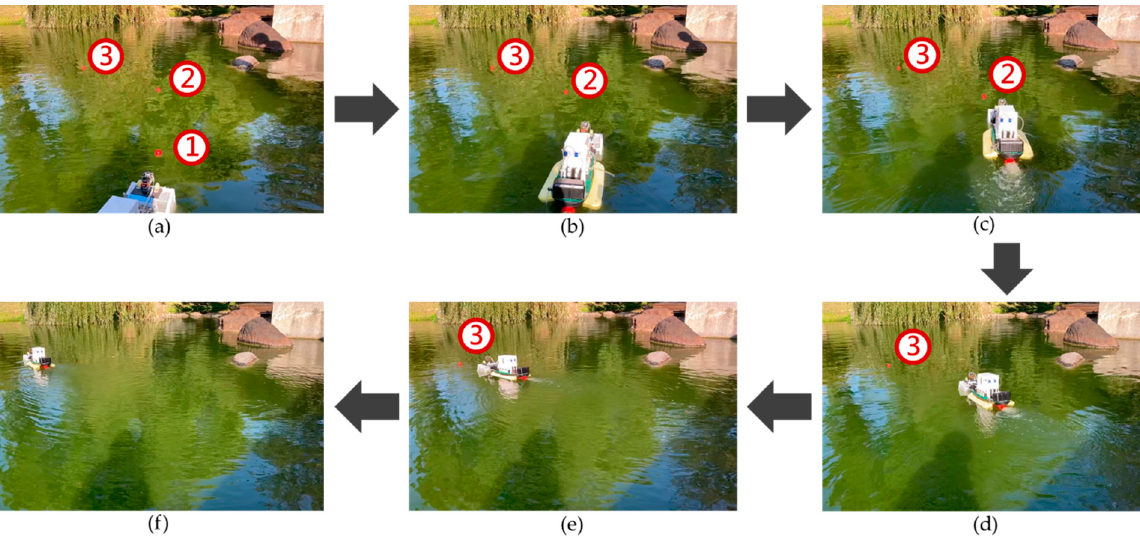
Figure 19. Experimental results for the water surface cleaning task. ( a ) When the first floating garbage is on the left front side of the vehicle, the MF-USV turns left about 15 ° for tracking the first floating garbage. ( b ) The first floating garbage is collected by the water surface cleaning device. ( c ) When the second floating garbage is on the left front side of the vehicle, the MF-USV turns left about 15 ° for tracking the second floating garbage. ( d ) The second floating garbage is collected by the water surface cleaning device. ( e ) When the third floating garbage is on the left side of the vehicle, the MF-USV turns left about 30 ° for tracking the third floating garbage. ( f ) The third floating garbage is collected by the water surface cleaning device.